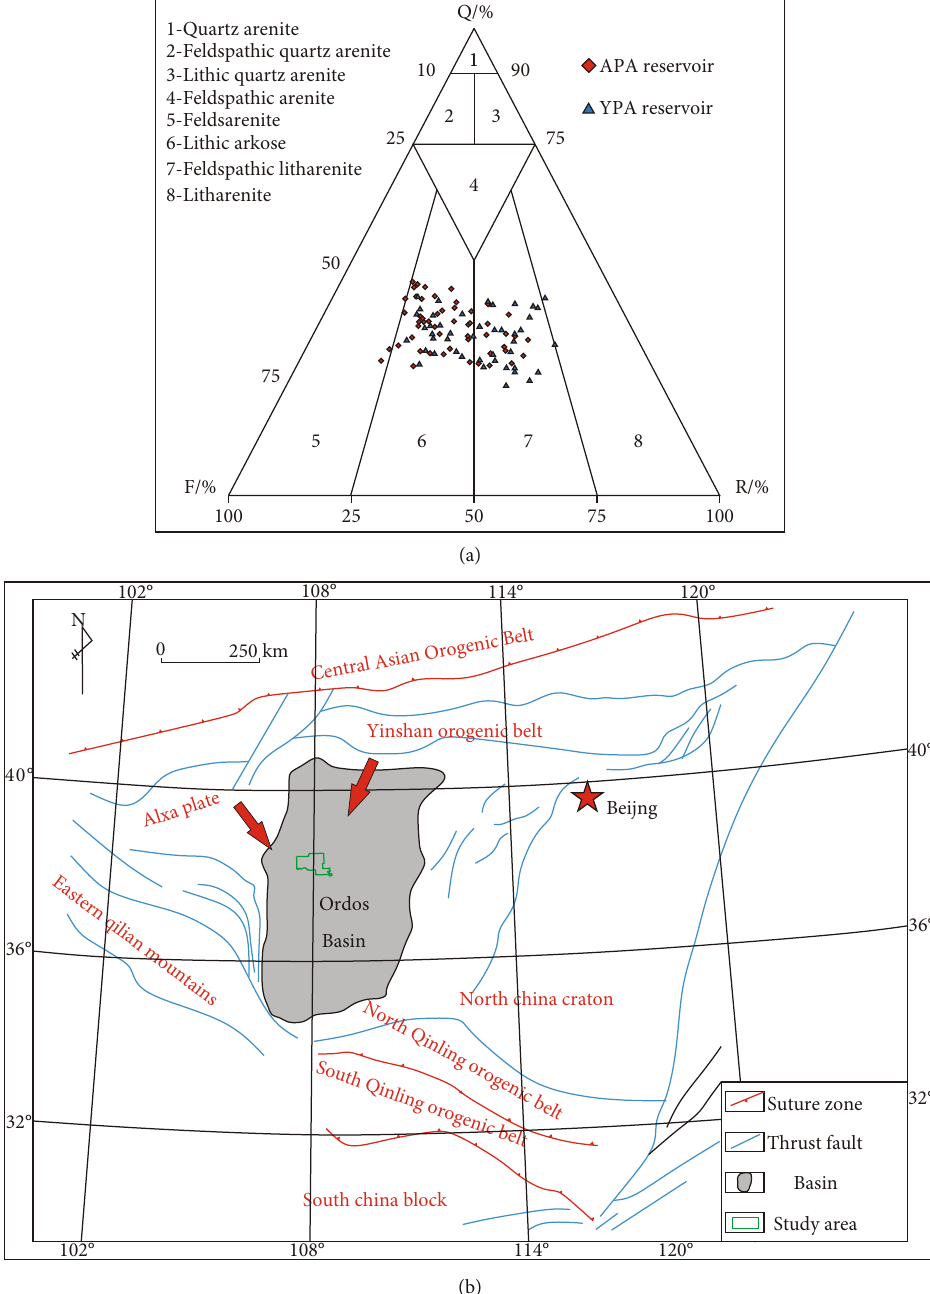
Figure 2: (a) Classi fi cation of sandstone in the Chang 8 bidirectional Provenance Location modi fi ed from